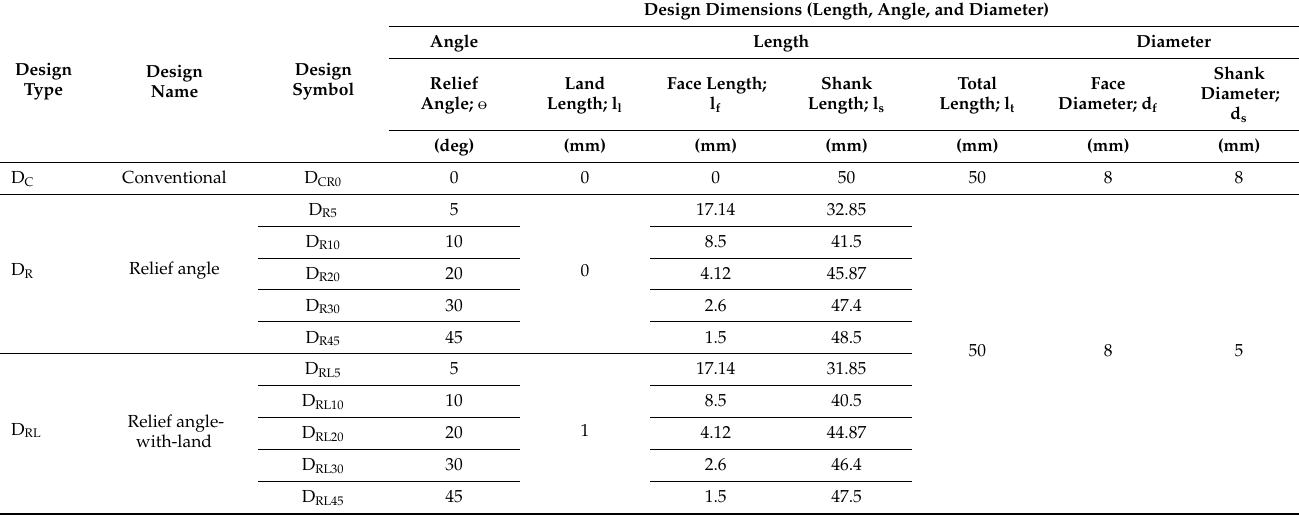
Figure 1. Electrode designs: ( a – c ) schematic of electrode designs, and ( d – f ) actual electrodes prepared after machining. Table 3. Major designs of electrode with detailed dimensions (length, angle, and